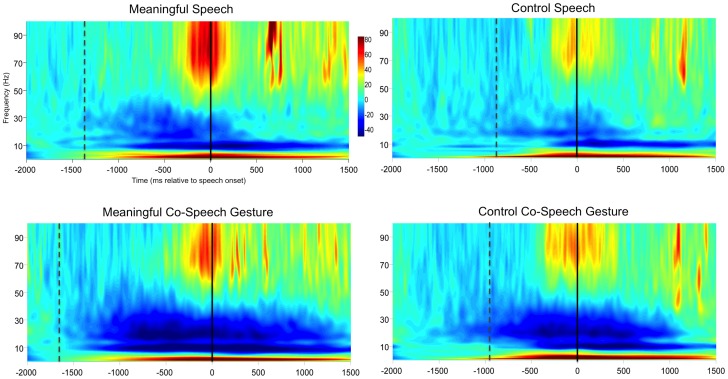
Results of time-frequency analysis for meaningful speech, meaningful co-speech gesture, control speech, and control co-speech gesture.Statistical analysis shows (i) a main effect of response, i.e., stronger beta-desynchronization for co-speech gesture than speech responses, and (ii) a main effect of condition, i.e., stronger gamma oscillations for meaningful than control trials. Solid lines indicate speech onset and dashed lines average time of stimulus presentation.